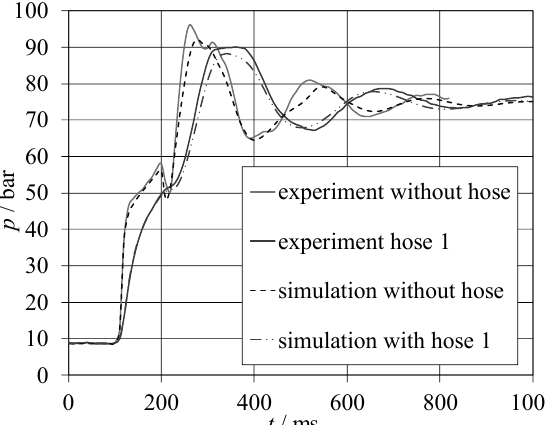
Fig. 6. Comparison between simulation and